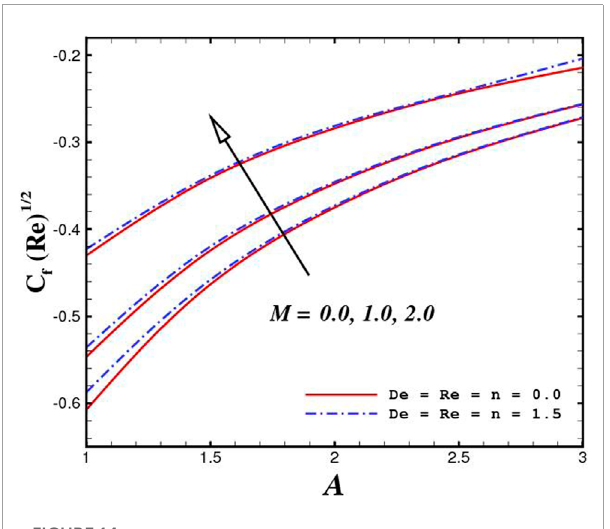
FIGURE 16 Nusslt Nu x √ Re x , sketch for frequent values of Nb and Nt.